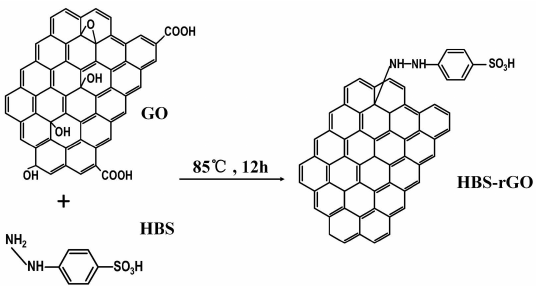
Figure 1. Reaction scheme for preparation of 4-hydrazinobenzenesulfonic acid (HBS) reduced graphene oxide (GO)